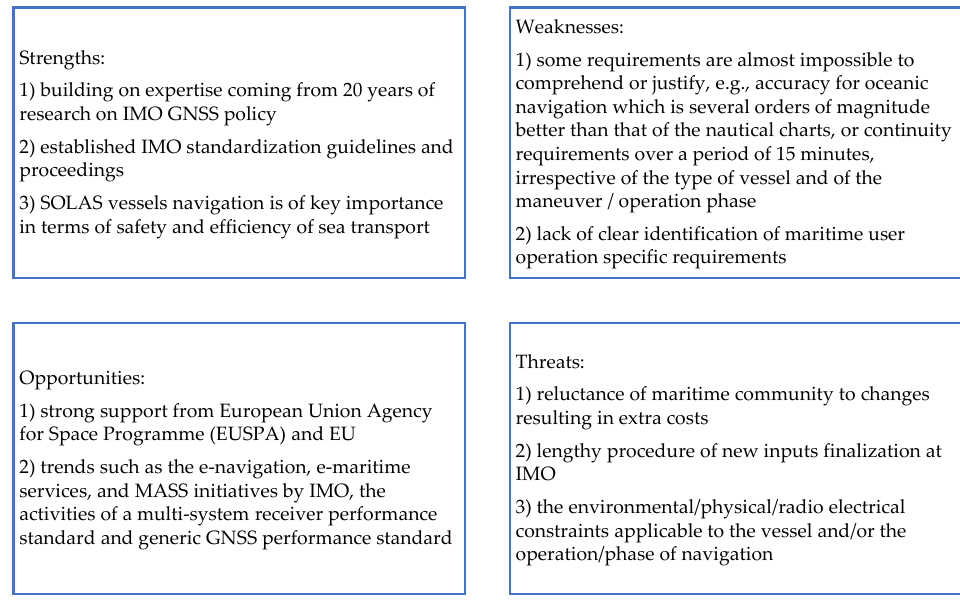
Figure 14. SWOT analysis of maritime GNSS standardization process.